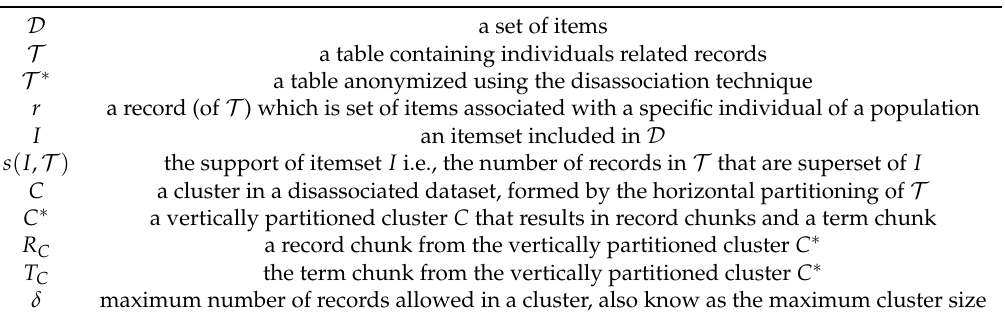
Table 1. Notations used in the